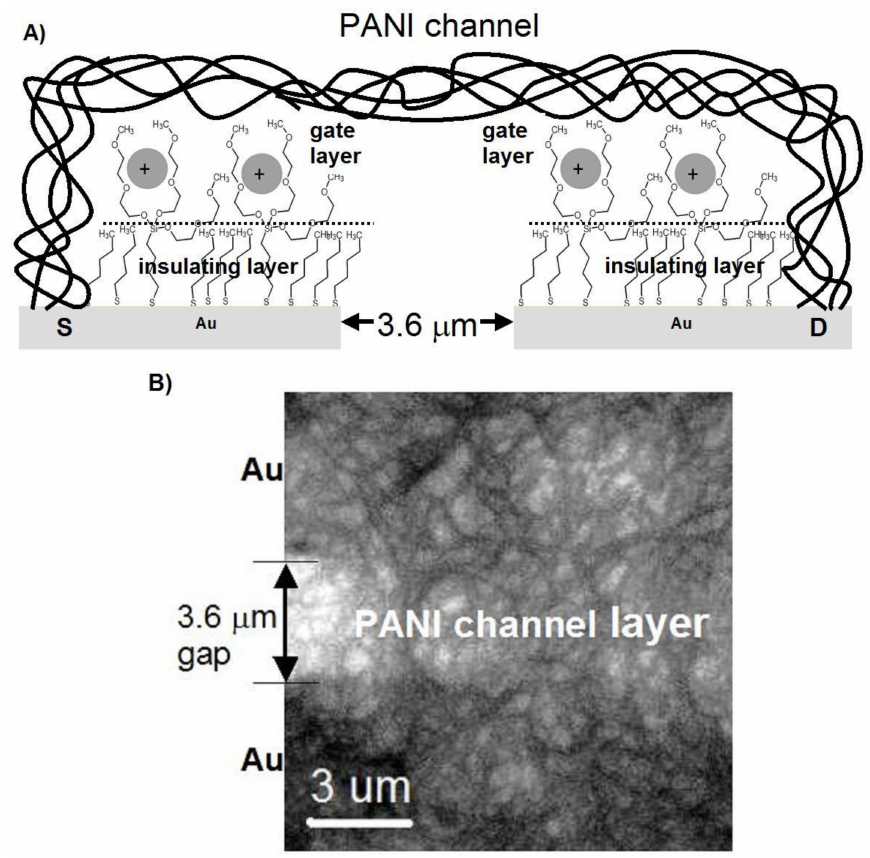
Figure 3. A nanodetector made of polyaniline nanofibers resembles an open-gate ion-sensitive organic field-effect transistor (ISOFET): ( A ) a cross-section (scheme) of the complex SAM Pnt-Si2t (“gate”) deposited onto the Au electrodes (“source” S and “drain” D) in contact with the cations, in vicinity of PANI nanofibrils (“channel”); ( B ) a morphology of the polyaniline network–the “FET channel” (top view, a Scanning Electron Microscope (SEM)